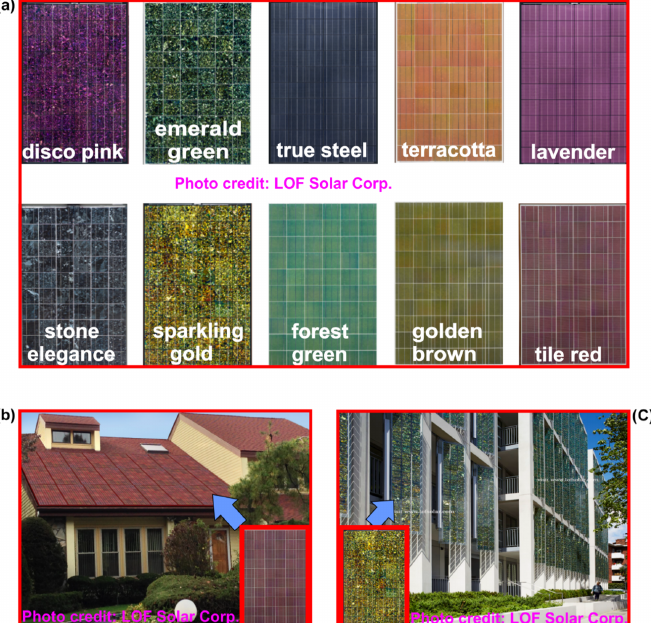
Figure 10. Crystalline Si-based opaque colored PV modules and their BIPV applications. ( a ) Various colored PV modules (reproduced and modi fi ed with permission from Ref. [95] ), ( b ) red-colored BIPV rooftop application (reproduced and modi fi ed with permission from Ref. [112] ), and ( c ) Sparkling gold BIPV façade application (reproduced and modi fi ed with permission from Ref. [114] ).